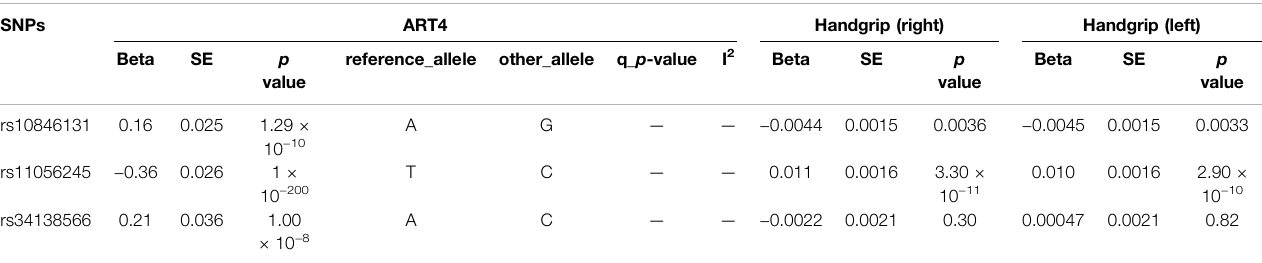
TABLE 4 | Correlation of Genetic IVs to ART4 and Handgrip (right and